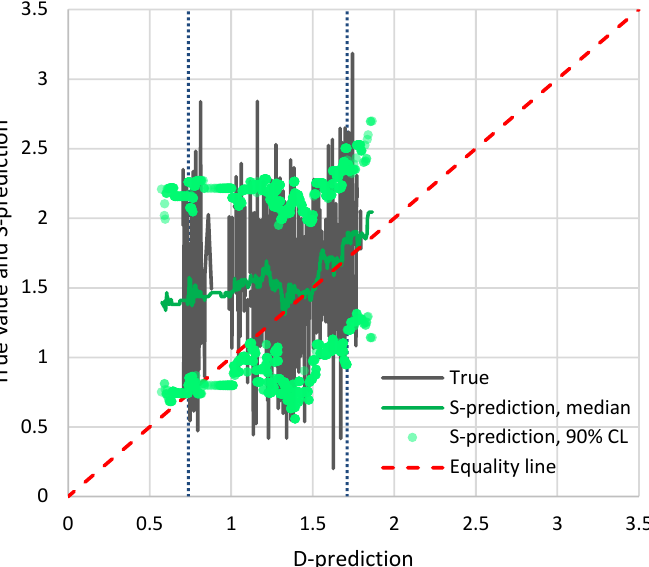
Figure 8. True values vs. D-model predictions for precipitation, transformed for normalization, along with S-model predictions (median and 90% confidence limits). The vertical dotted lines define the area out of which extrapolation is necessary.